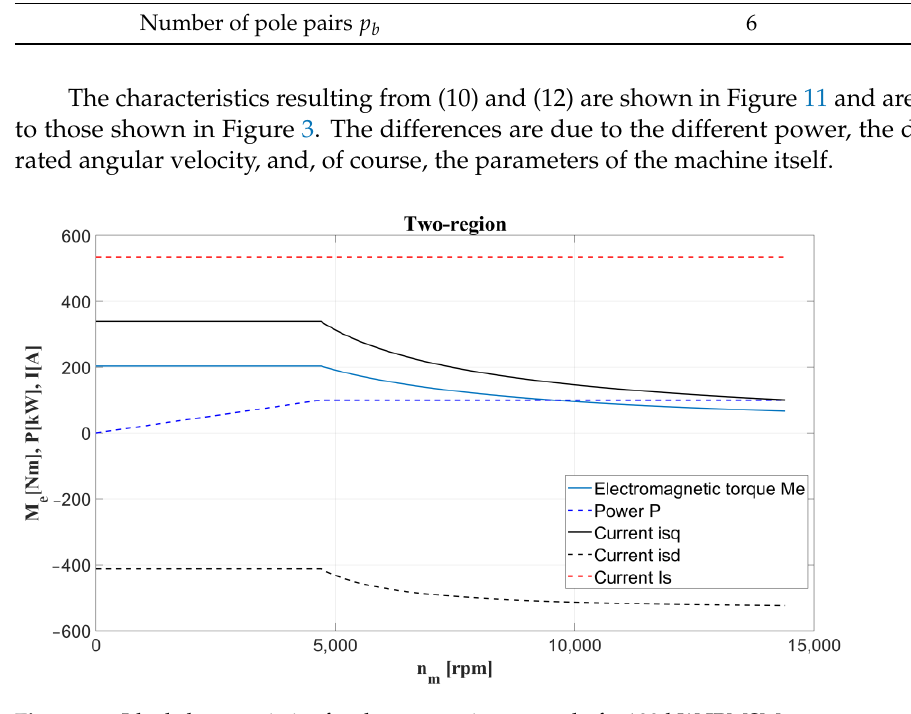
Figure 11. Ideal characteristics for the two-region control of a 100 kW IPMSM.